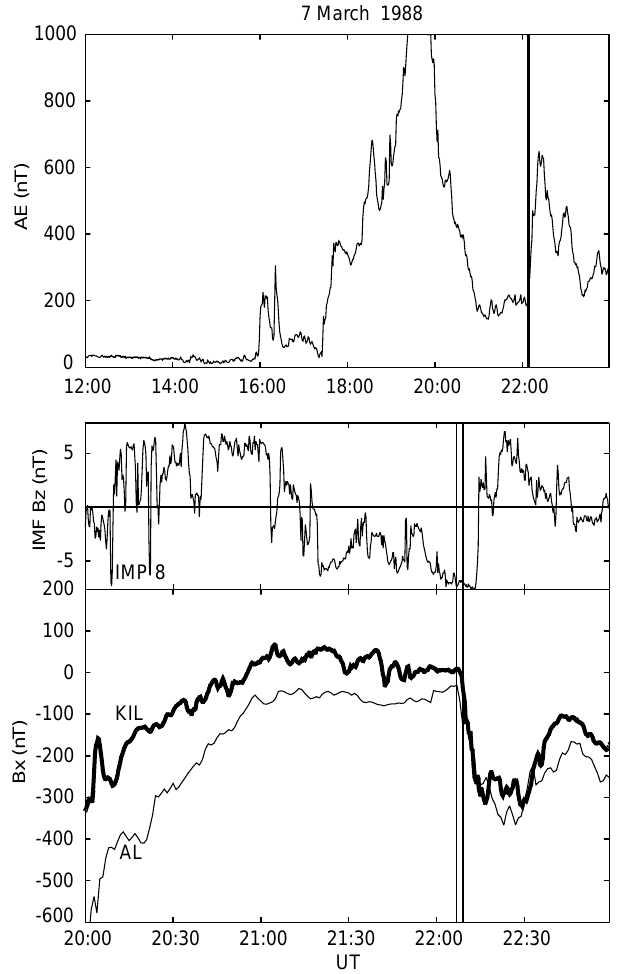
Fig. 6. Fading event on 7 March 1988: ( top panel ) AE index, ( middle panel ) IMF B z in GSM coordinates recorded by IMP-8 (satellite location: X GSM from 17.8 to 15 : 9 R E , Y GSM from 27.2 to 28 : 4 R E , and Z GSM from 2.2 to 3 : 9 R E ), and ( bottom panel ) AL index ( thin line ) together with the local B x magnetogram from KIL ( heavy line ). The vertical lines mark the fading and breakup